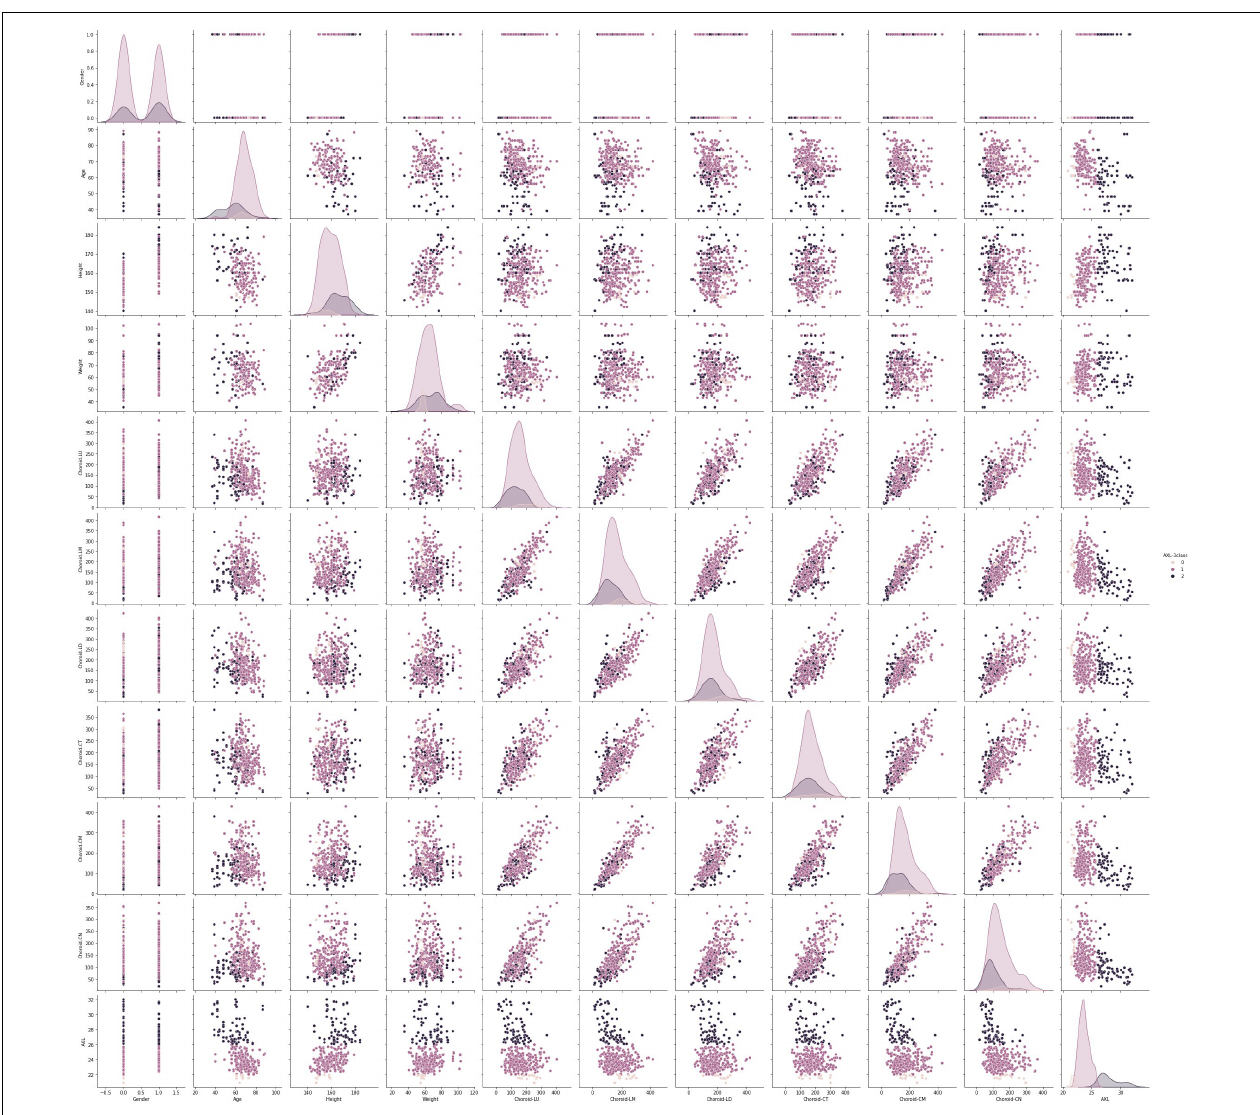
FIGURE 4 | Pairwise scatter plots of all features with multiclass